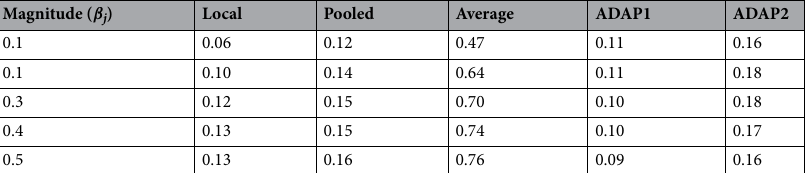
Magnitude ( β j ) Local Pooled Average